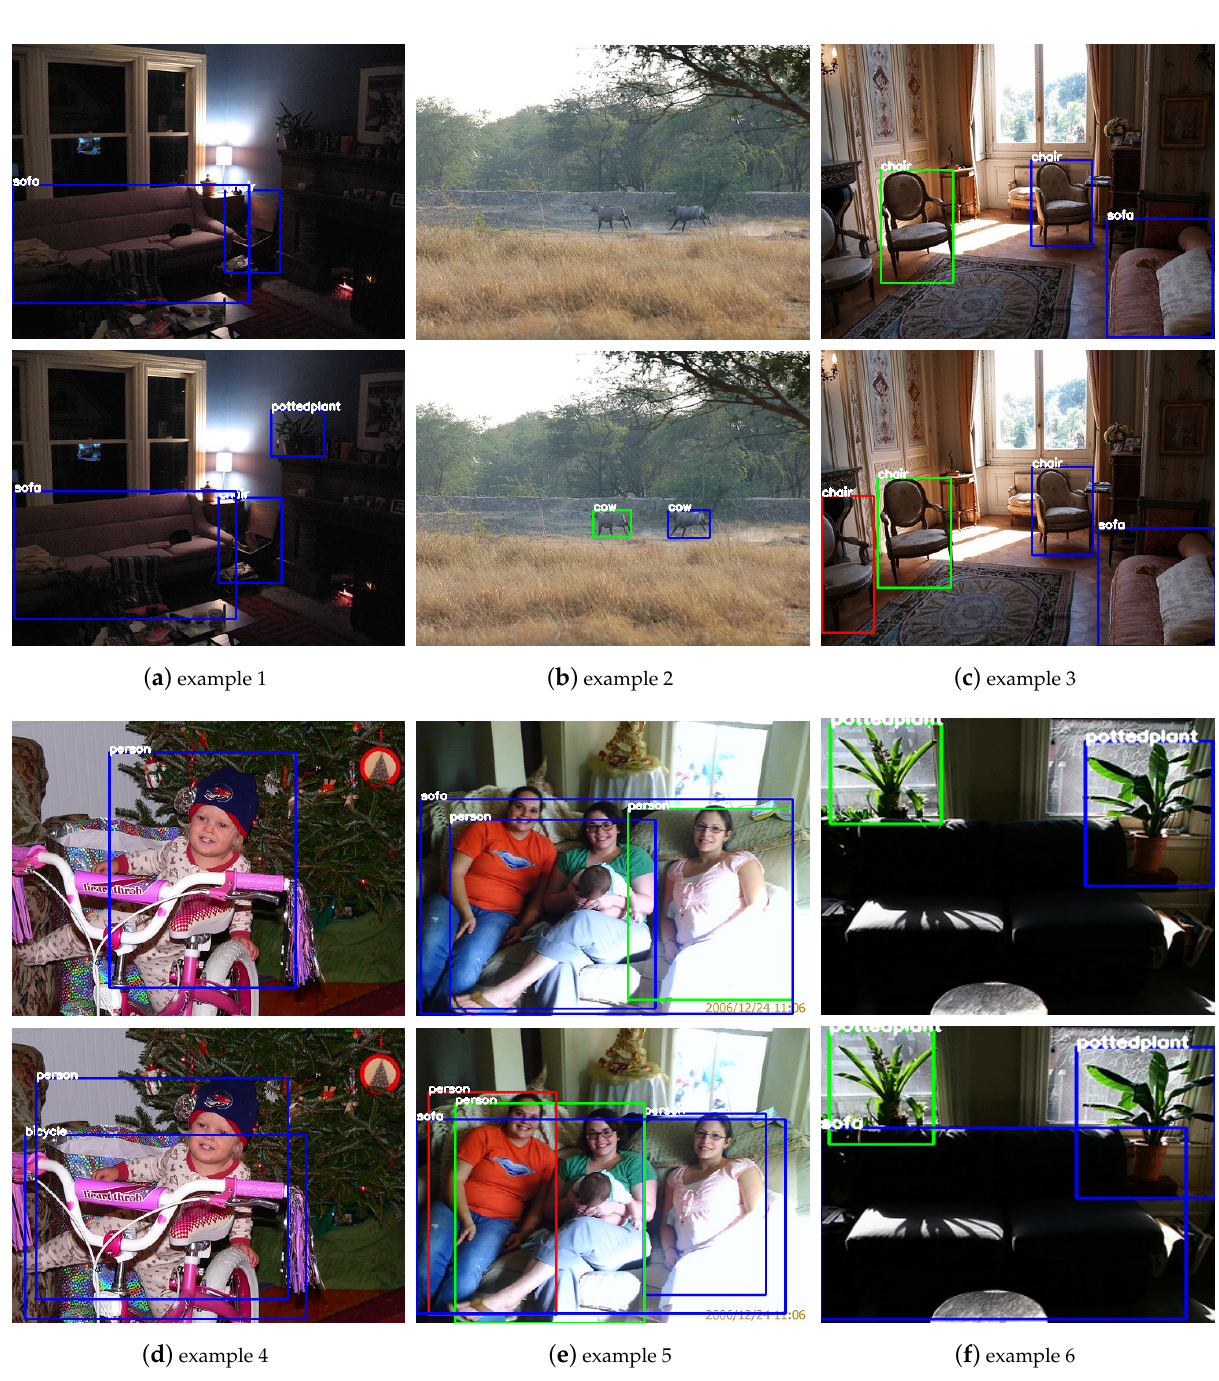
Figure 5. Some detection results from VOC 2007 test . Upper: SSD. Lower: Ours. See more details in Section 4.6. Adapted from